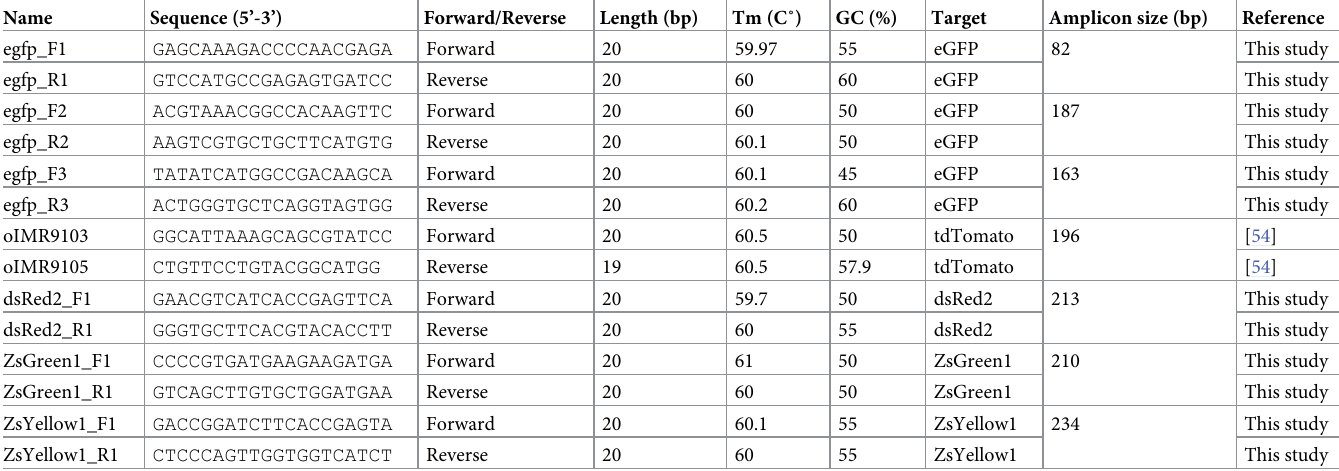
Table 1. Primers for PCR amplification of transgenic